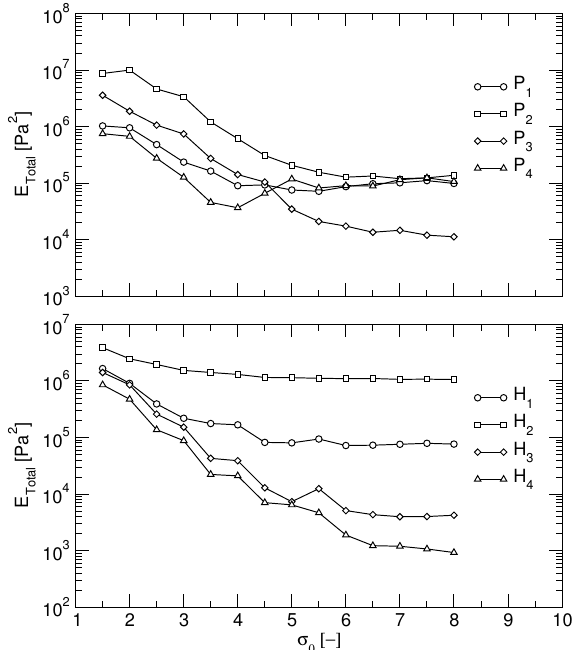
Figure 8. Energy integral of the fluctuating pressure versus the cavitation number at the wall (P-probes, top ) and in the fluid (H-probes, bottom